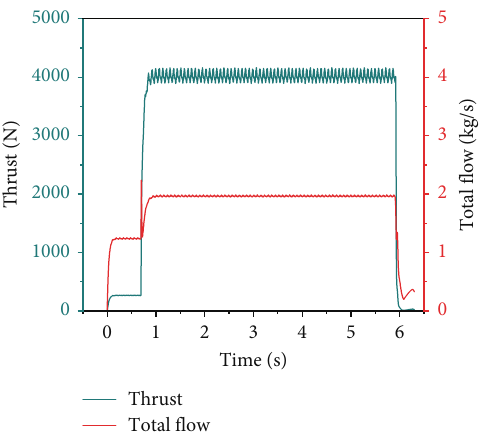
Figure 8: The thrust and total fl ow of the pretest condition.